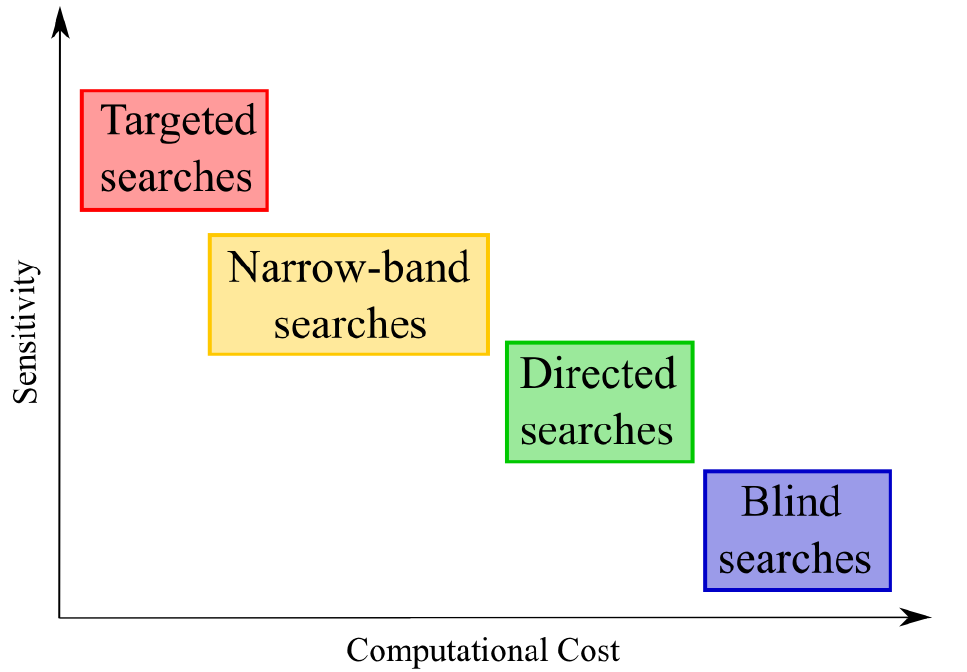
Figure 3. Schematic plot of the sensitivity versus computational cost of the different CGWs searches